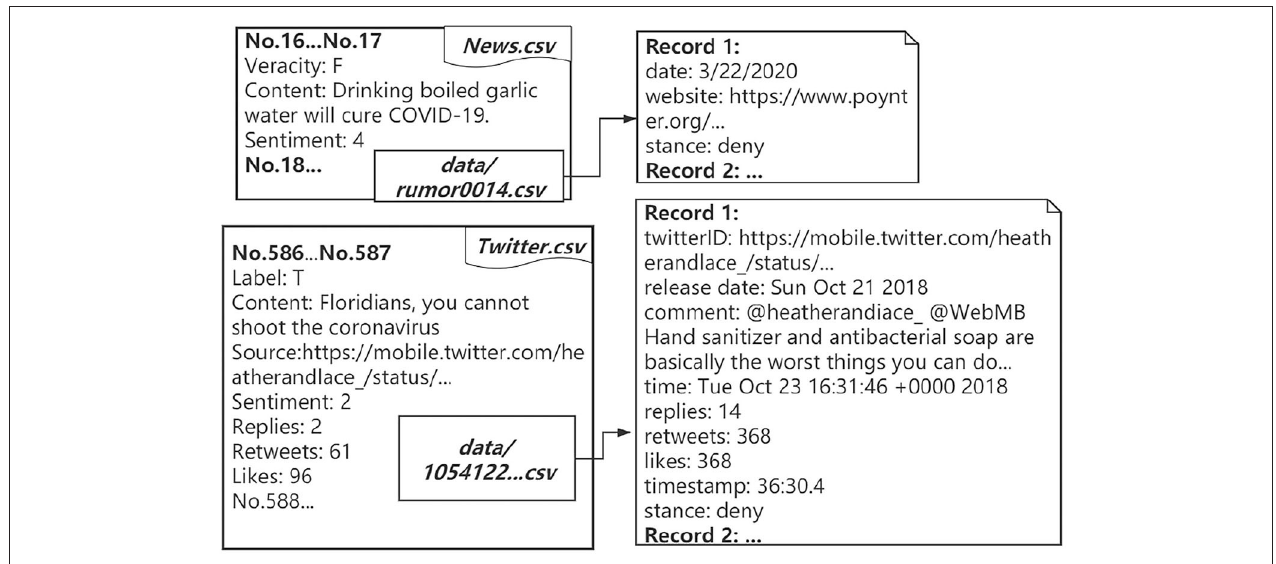
FIGURE 1 | Examples of data structure.